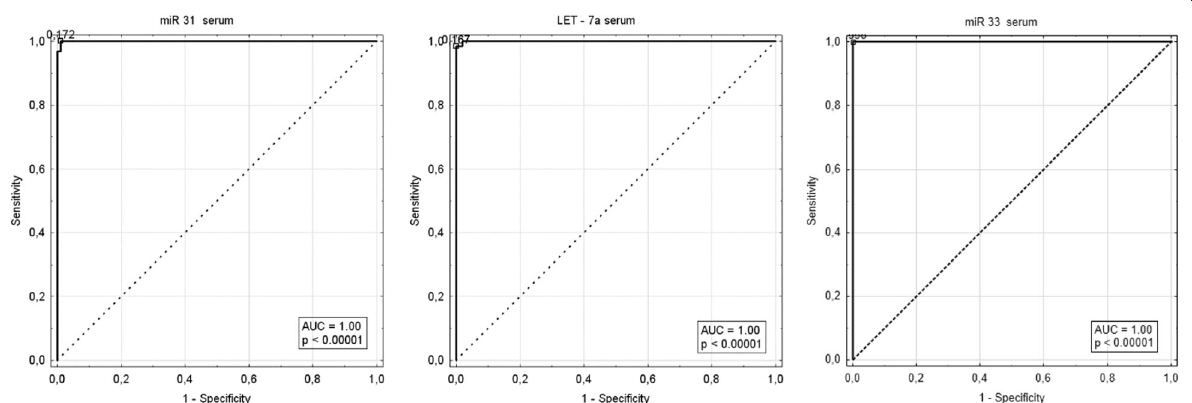
Fig. 3 Receiver operator characteristic curve analysis using serum miR-31, LET-7a and miR-33 for discriminating LSCC patients. Serum miR-31, LET-7a and miR-33 were able to diagnose LSCC with a sensitivity of 100, 98, 100%, and specificity of 99,100 and 100%, respectively, as compared with healthy controls